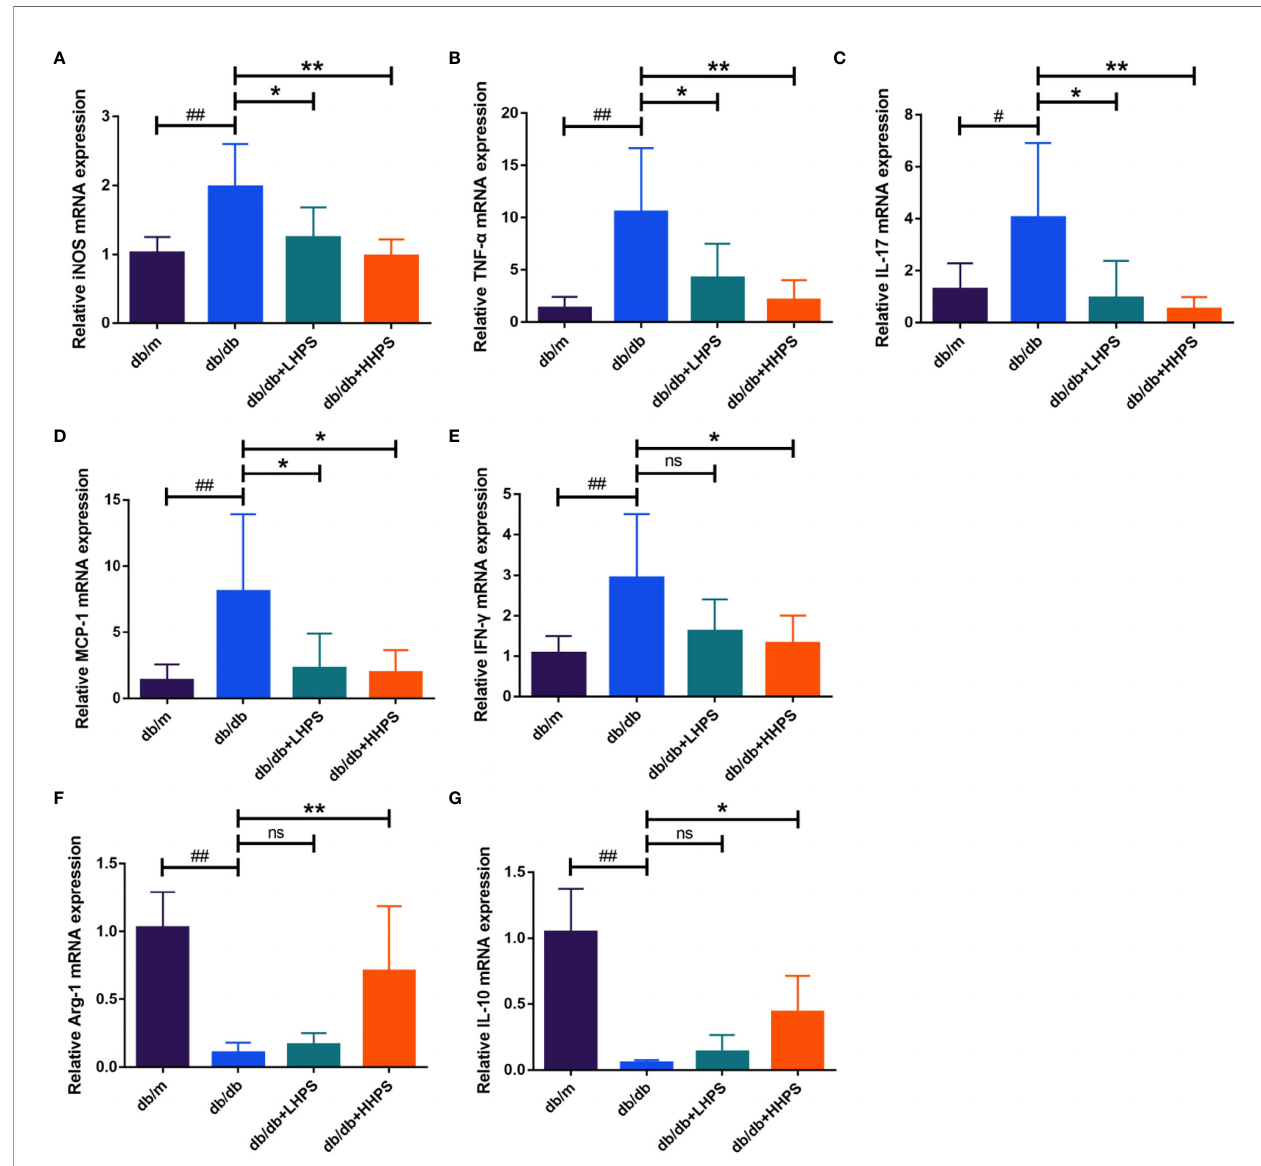
FIGURE 4 | Hyperoside reduces the expression of proin fl ammatory cytokines while increasing the expression of anti-in fl ammatory cytokines in the kidney. Quantitative real-time PCR analysis of the proin fl ammatory cytokines iNOS (A) , TNF- a (B) , IL-17 (C) , MCP-1 (D) and IFN- g (E) , and anti-in fl ammatory cytokines Arg-1 (F) and IL-10 (G) in the kidney tissue in four groups following HPS treatment: db/m , db/db , db/db +LHPS, and db/db +HHPS mice. Relative mRNA expression levels were normalized to b -actin. Data are representatives of three independent experiments and presented as means ± SD (n = 6 per group, # P < 0.05 and ## P < 0.01 vs db/m ; * P < 0.05 and ** P < 0.01 vs db/db; ns, not signi fi